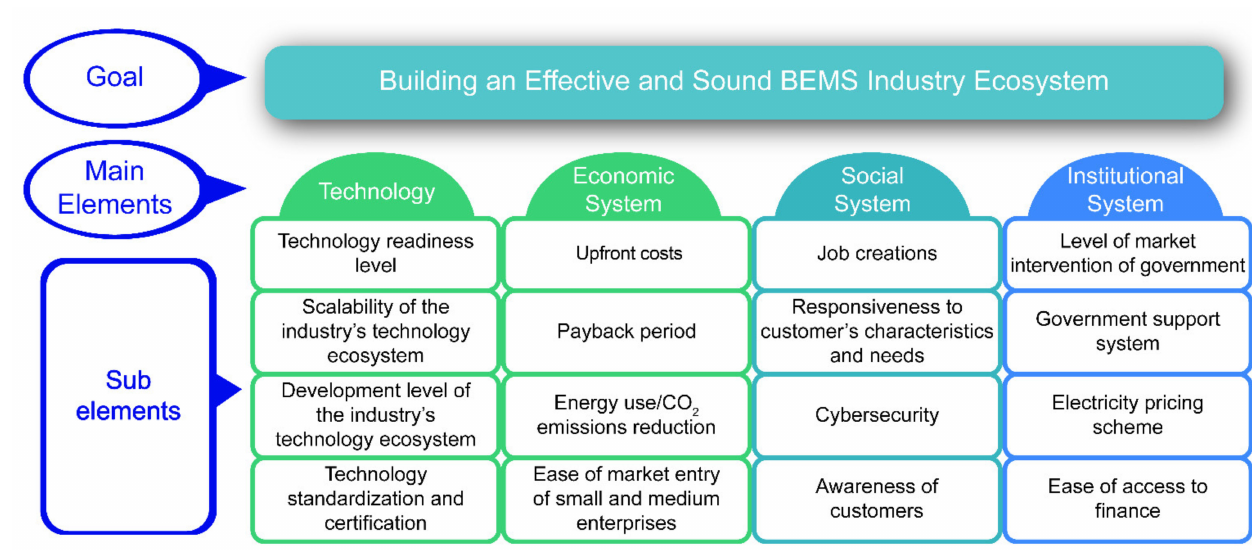
Figure 2. Hierarchical structure of the AHP survey on the BEMS industry ecosystem.